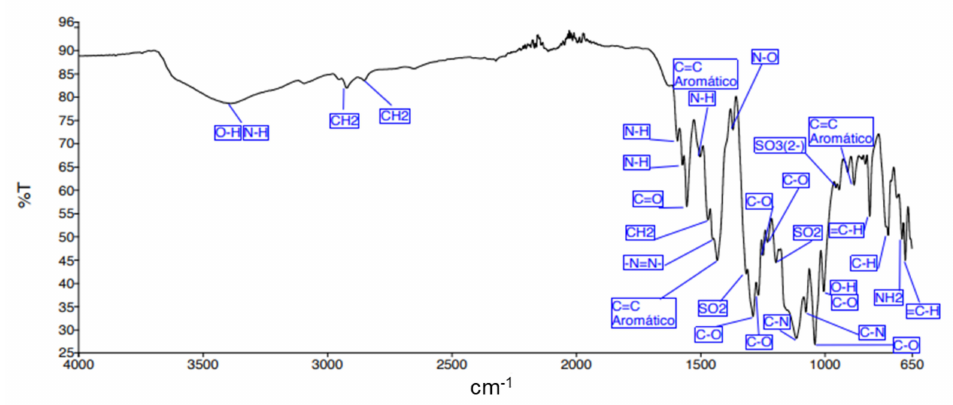
Figure 4. Infrared spectrum of the Red G dye identifying the bands with their functional